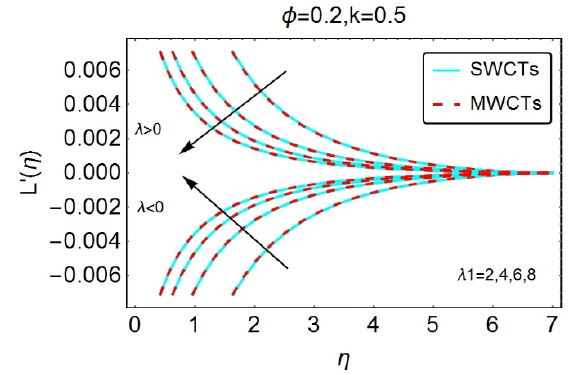
(cid:48) ( η ) for velocity parameter λ